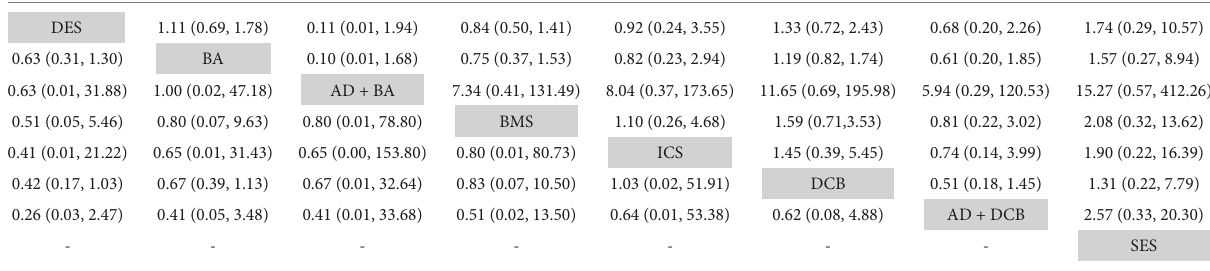
TABLE 5 Comparison results of network meta-analysis on 12-month major amputation (left) and 12-month all-cause mortality (right).